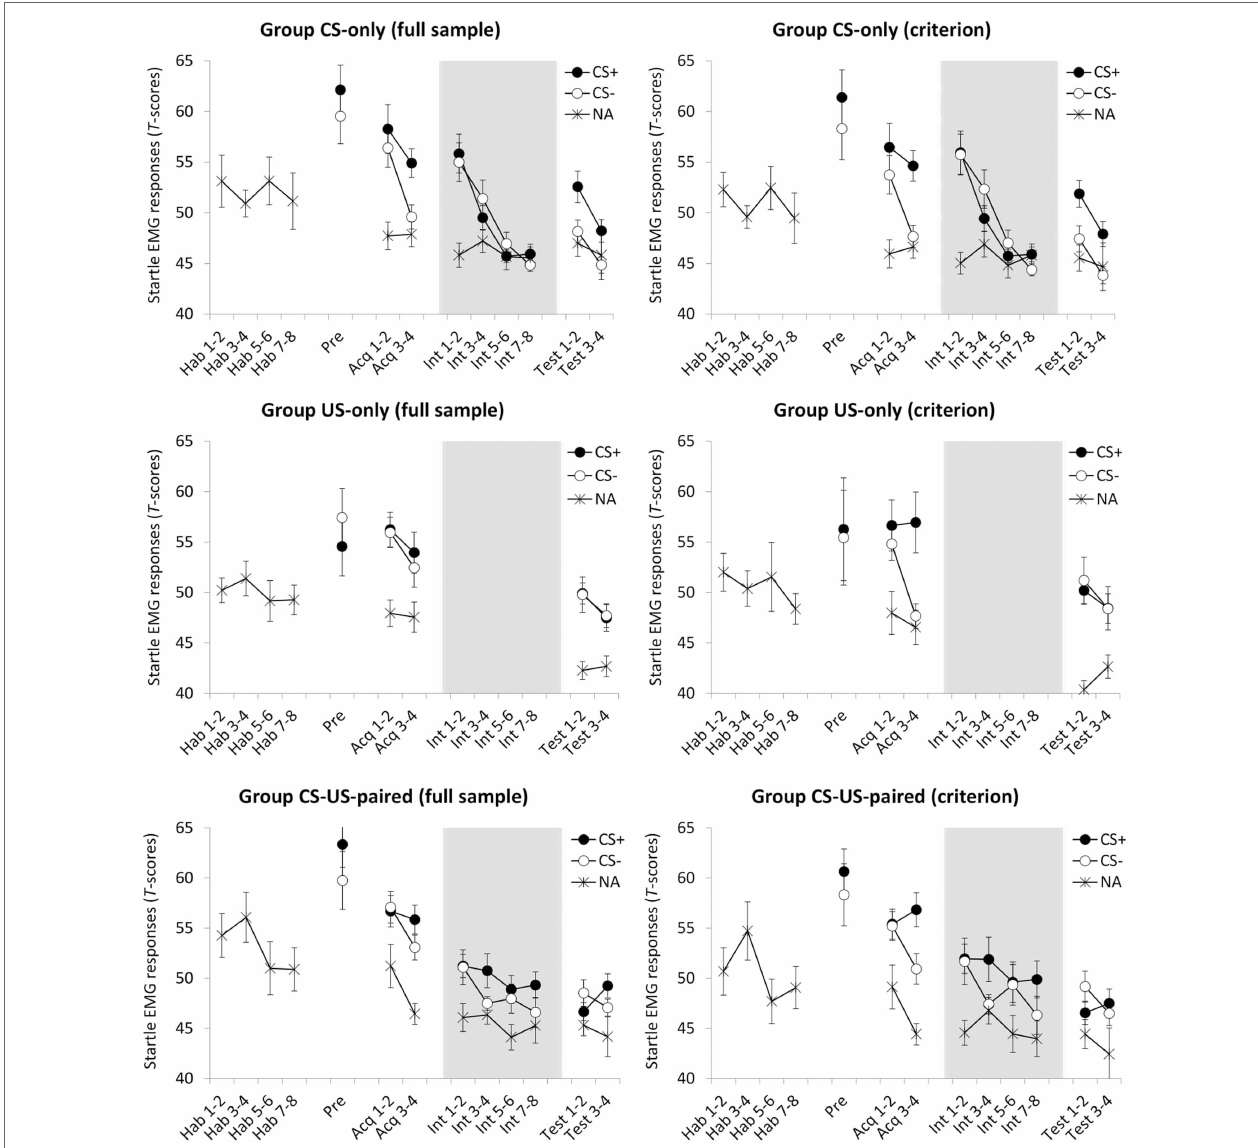
FIGURE 3 | Mean standardized fear-potentiated startle (FPS) responses for groups CS-only, US-only, and CS-US-paired as a function of stimulus type (CS + /CS (cid:0) /NA) and trial, presented for the full sample (left panel) and for the criterion sample (right panel; only including participants that showed differential startle EMG responding during the last acquisition block). Hab, habituation trial; Pre, pre-test trial Acq, acquisition trial; Int, intervention trial; Test, test trial; NA, noise alone, i.e., startle probe presentation during half of the intertrial intervals. All groups received eight probe habituation trials, one CS-pre-exposure trial and four acquisition trials. Four test trials followed eight CS-alone presentations (group CS-only) eight US-alone presentations (group US-only) or eight continued CS–US pairings (group CS-US-paired). Background colors represent the experimental contexts. Error bars represent SEMs. Note that the data in this plot represent FPS magnitudes standardized across all test trials. These data were only used in ANOVAs that tested within-subject effects. ANOVAs that tested between-subject effects were performed on data that were T-transformed over all trials except the intervention trials (since the content of these trials was manipulated between groups).